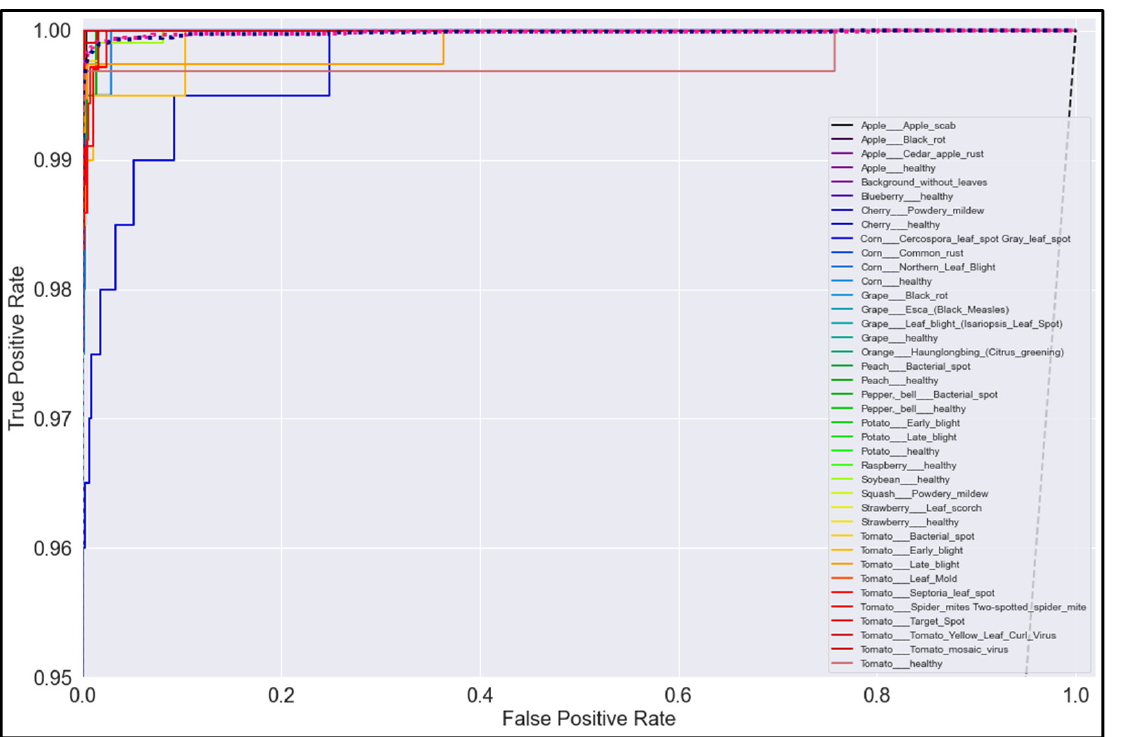
Figure 21. ROC Curve for NasNetMobile model with transfer learning Scenario 3 and Proposed hy- perparameters.